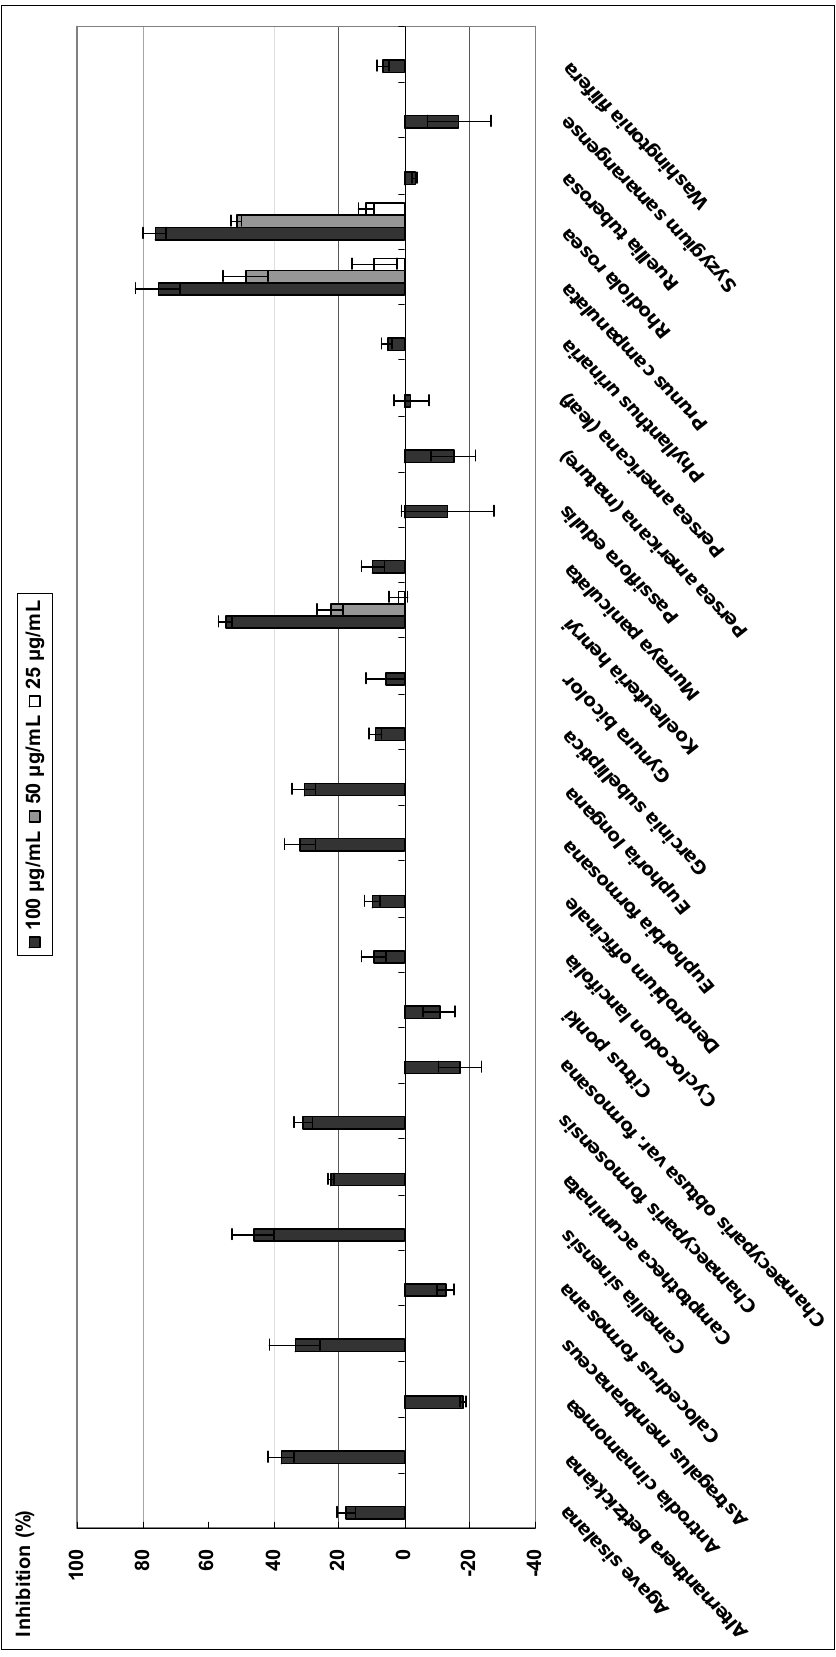
Figure 1. Inhibitory effect of 27 plant acetone extracts on xanthine oxidase